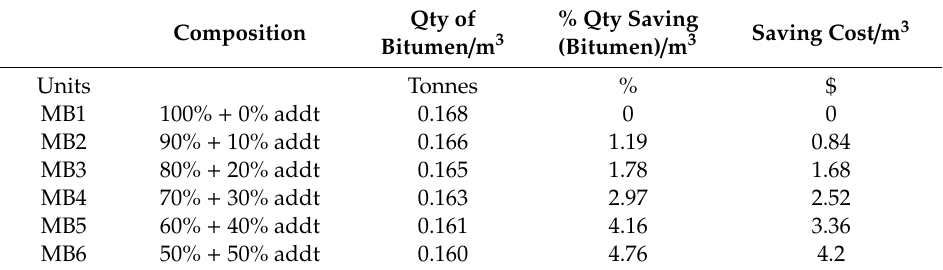
Table 6. Description of bitumen saving per m 3 of asphalt mix.